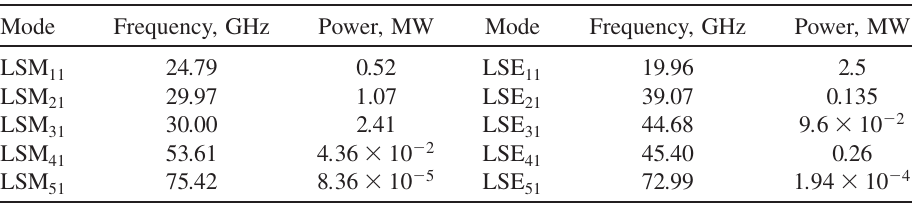
TABLE II. Eigenfrequencies of two-channel structure and radiation power for the Gaussian distribution of charge within the 50 nC drive bunch.